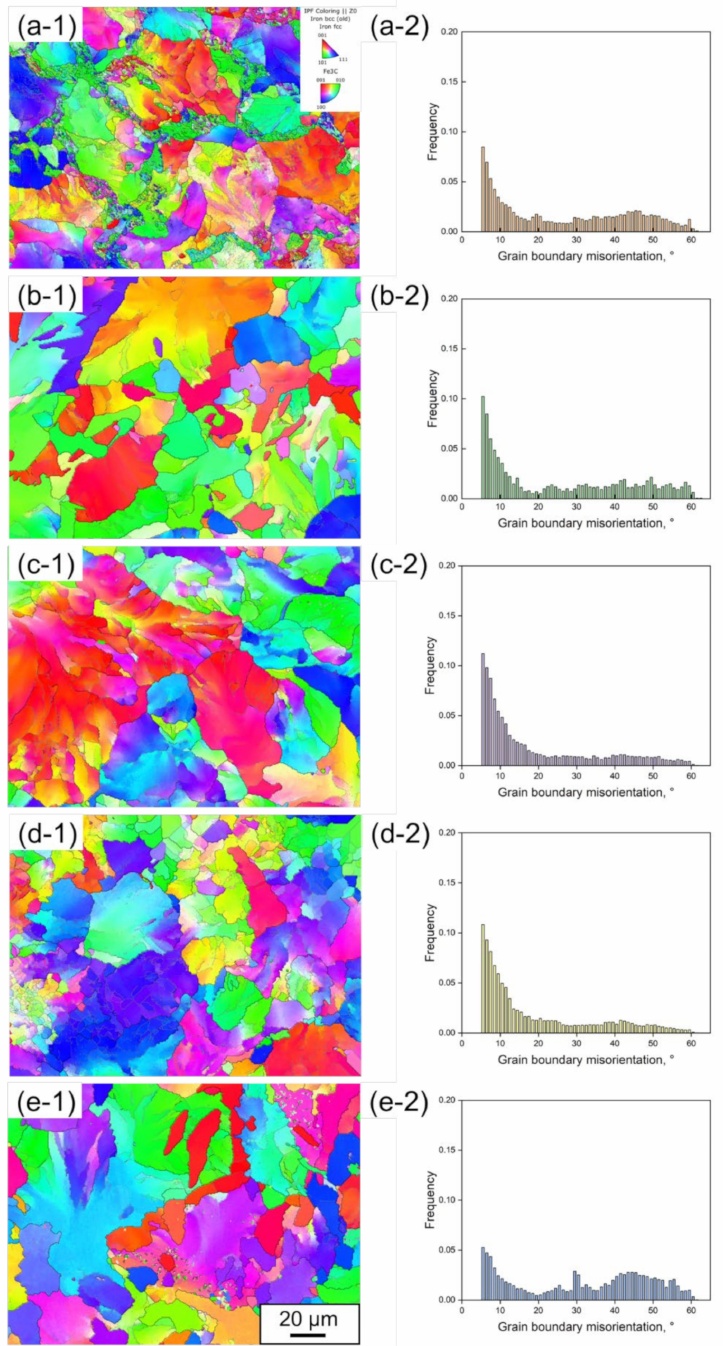
Figure 4. IPF + grain boundary maps and corresponding distribution diagrams of grain